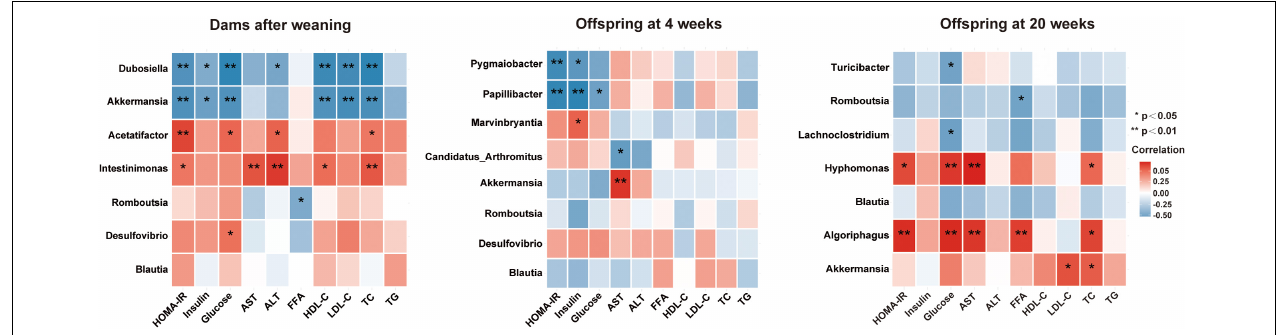
FIGURE 7 | Heatmap of the correlation analysis between the altered genera and glucose and lipid metabolic parameters in dams and offspring. Correlation results in dams after weaning and in offspring at 4 and 20 weeks of age are shown. HOMA-IR, the homeostasis model assessment of insulin resistance; GLU, glucose; AST, aspartate aminotransferase; ALT, alanine transaminase; FFA, free fatty acid; HDL-C, high-density lipoprotein cholesterol; LDL-C, low-density lipoprotein cholesterol; TC, total cholesterol; TG, triglyceride. Values show a significant correlation between the genera and metabolic parameters: * p < 0.05 and ** p <